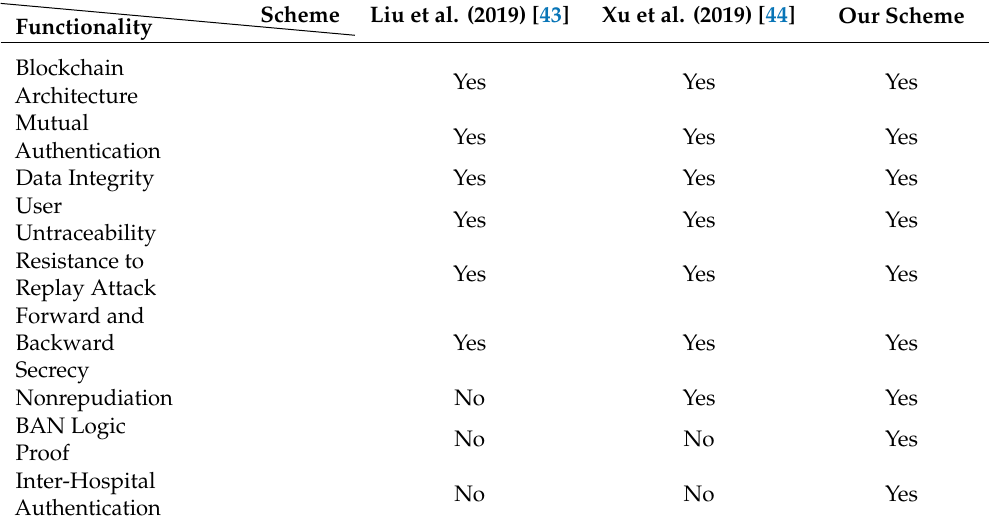
Table 4. Functionality comparison of previous schemes and the proposed